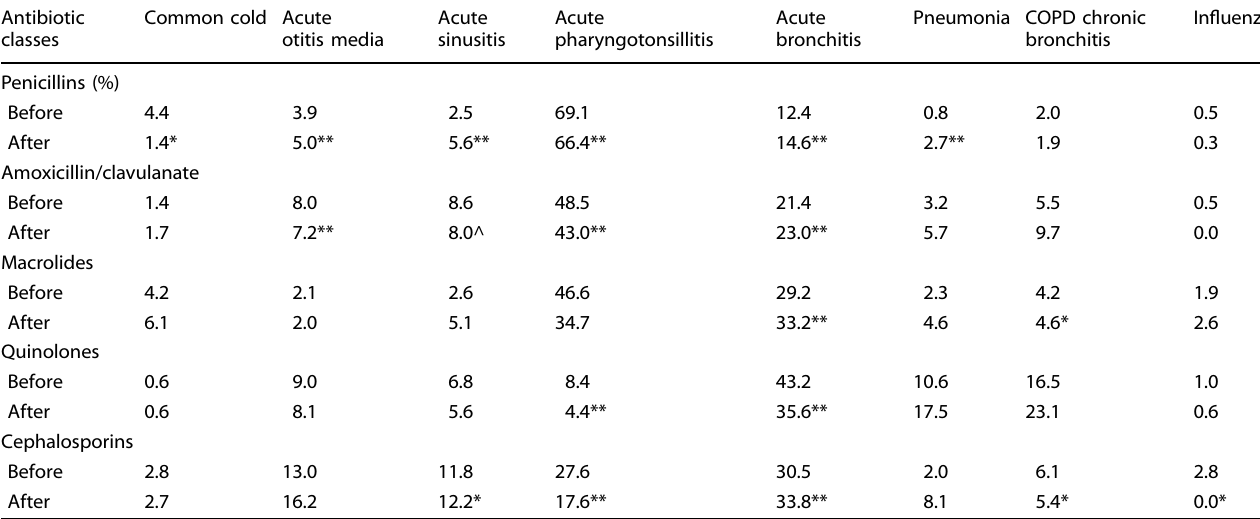
Table 5. Changes in the percentage of use of the different antibiotic classes before and after the physician ’ s educational intervention for the different pathological